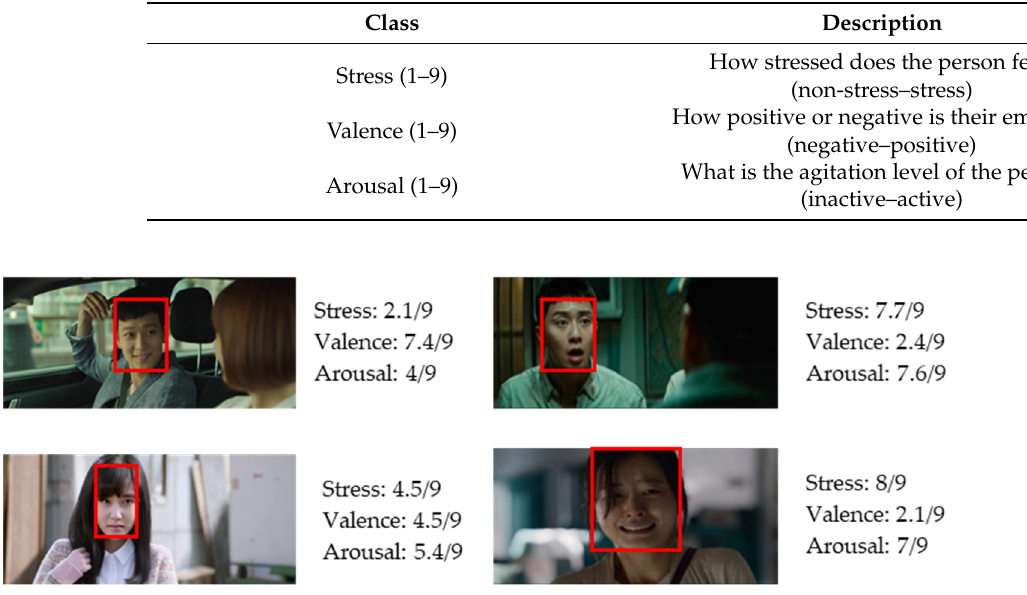
Table 2. Description of the stress and dimensions of valence and arousal.